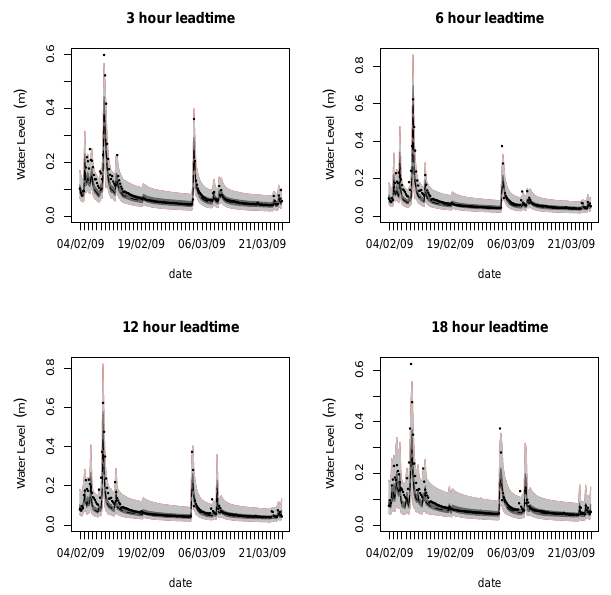
Fig. 8. Validation of Quantile Regression method for water level forecasts at Manor House Gardens for the February 2009 event for 3, 6, 12 and 18h lead times. The dark grey area represents the 50% confidence interval and the light grey area represents the 90% confidence interval, the black dashed line the 50% estimate, and the black dots the